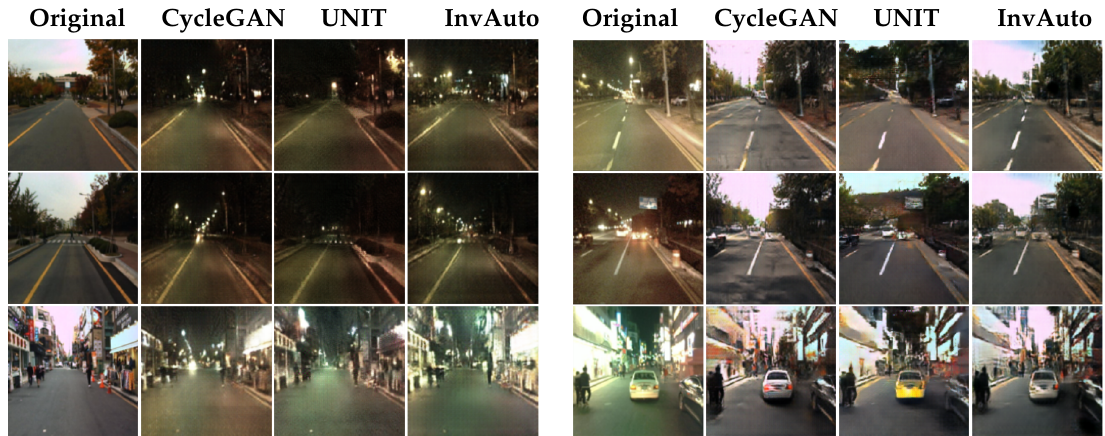
Figure 6. ( Left ) Day-to-night image conversion. Zoomed image is shown in Figure A5 in Appendix A. ( Right ) Night-to-day image conversion. Zoomed image is shown in Figure A6 in Appendix A. Original CycleGAN UNIT InvAuto Reference Original CycleGAN UNIT InvAuto Reference